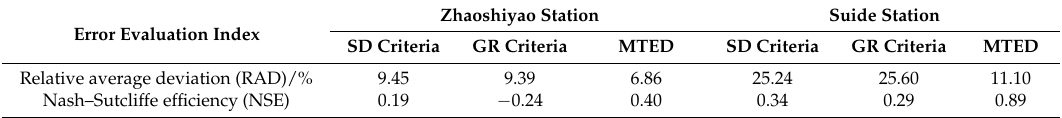
Table 2. Error assessment of improved EEMD prediction models based on three stopping criteria.